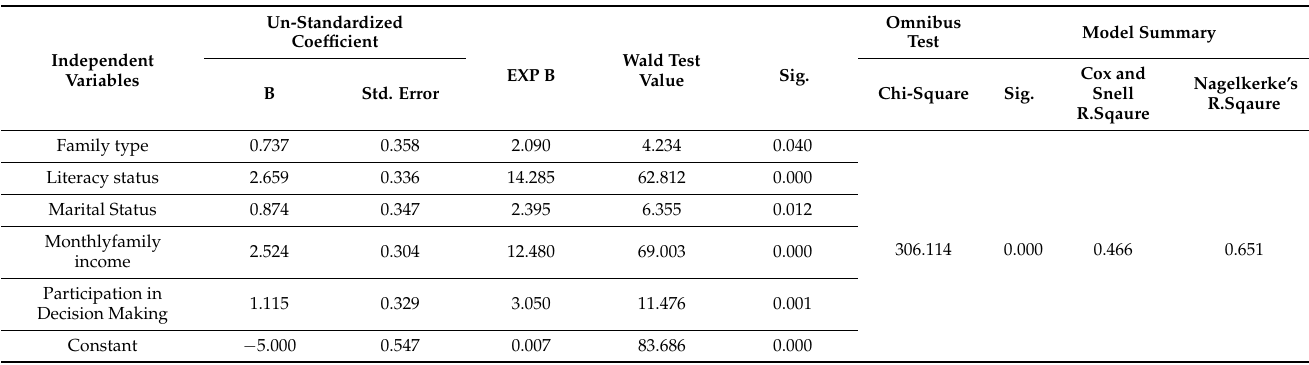
Table 7. Influence of family type, literacy status, marital status, monthly family income and participa- tion of decision making on social inclusion of